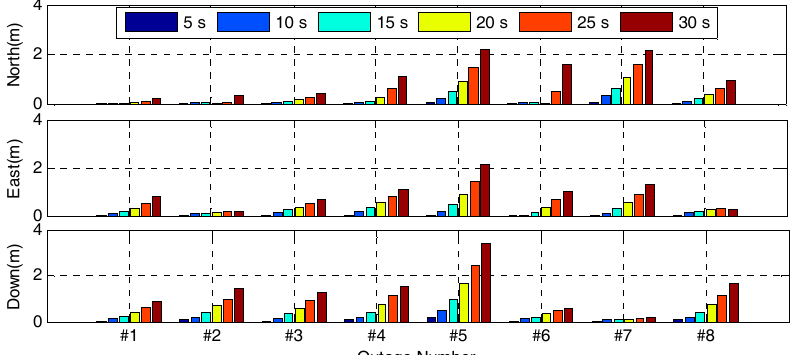
Figure 19. Position drift errors of the tightly-coupled RTK/INS integration during GNSS outage durations of 5, 10, 15, 20, 25 and 30 s using the GPS/BDS/GLONASS observables.